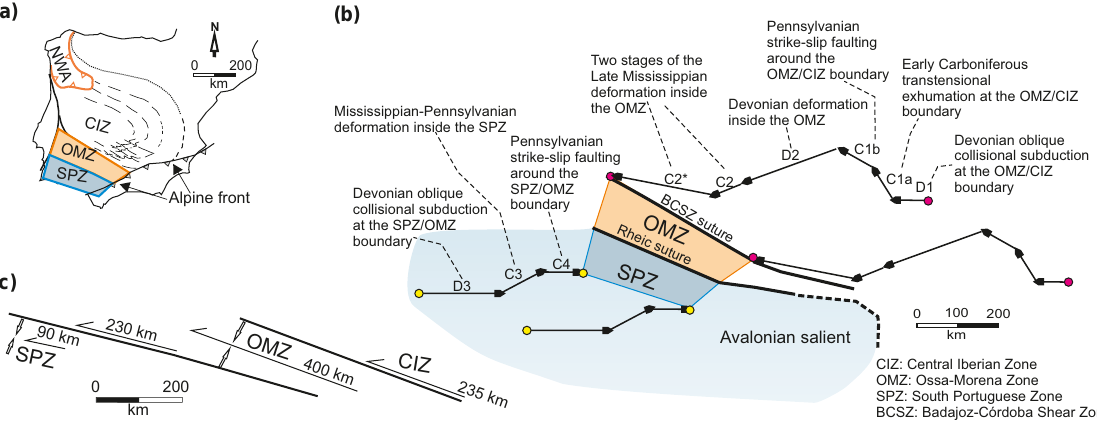
Figure 10. (a) Sketch of the Iberian Massif with location of the CIZ, OMZ, SPZ and the NW Iberia allochthon (NWA). (b) Vectors show- ing the relative displacements between the southern Iberia terranes, according to our calculations. (c) Sketch emphasizing the left-lateral displacements parallel to terrane